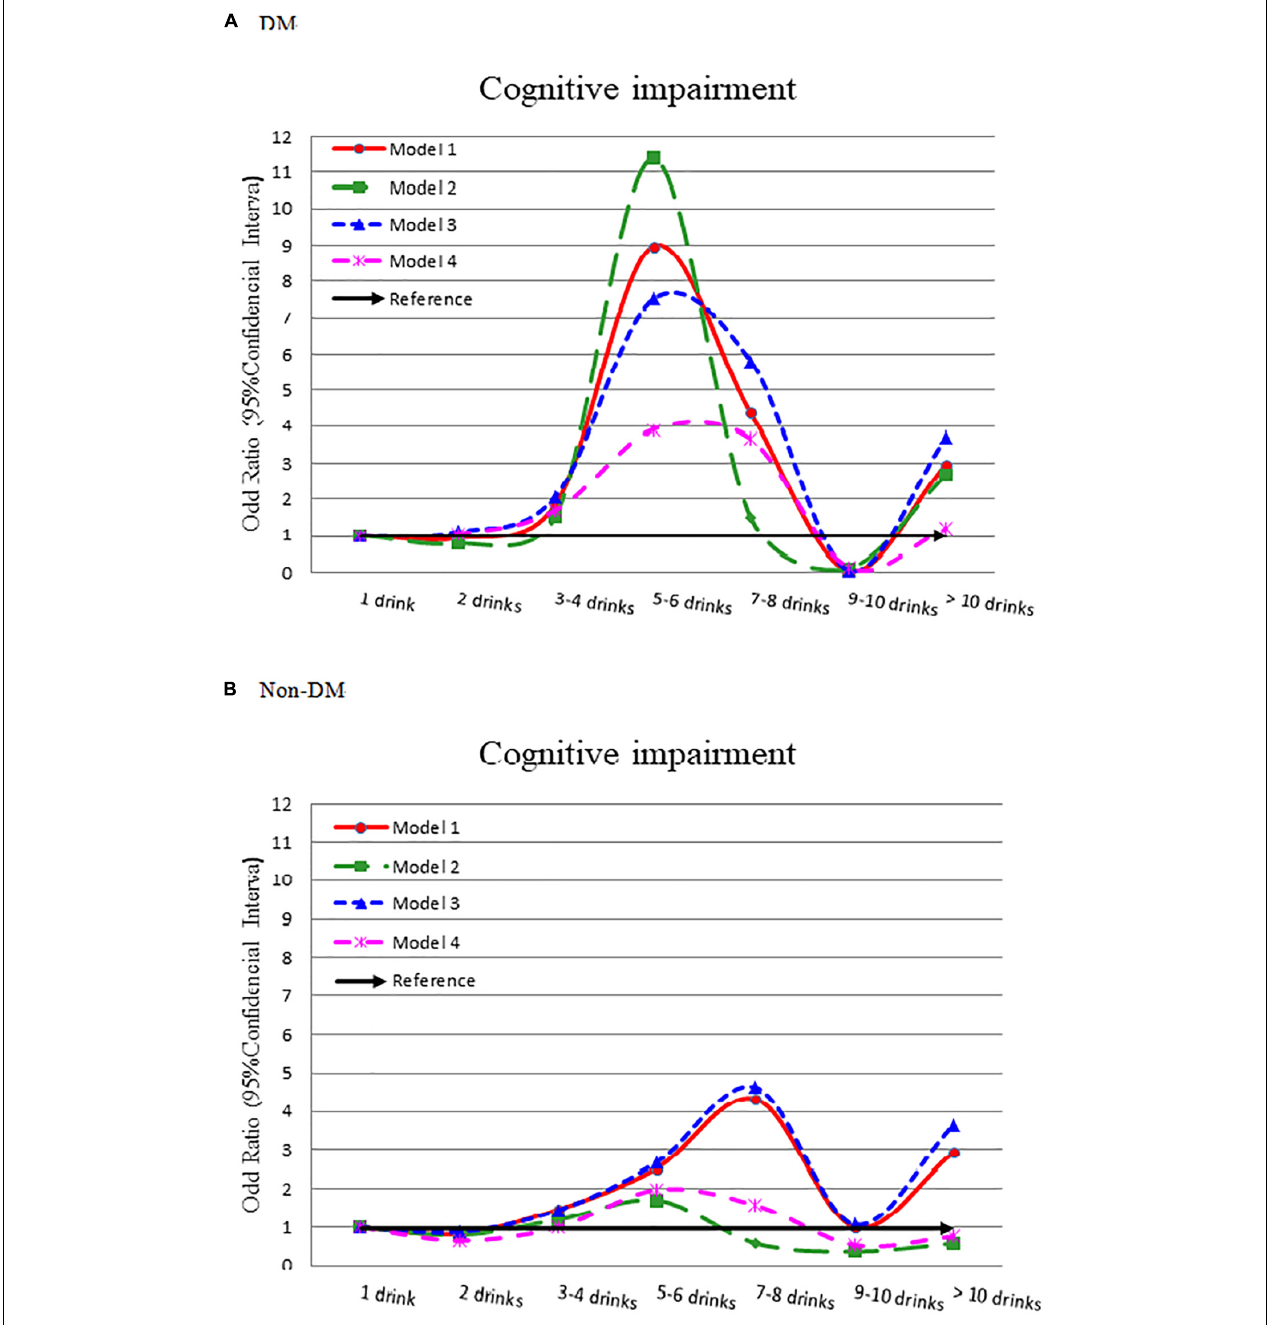
FIGURE 1 | Odds ratio for cognitive impairment by different alcohol consumption categories-stratified by diabetes. (A) With diabetes and (B) without diabetes. Model 1: crude OR (95%CI). Model 2: adjusted for demographic variables. Model 3: adjusted for comorbidity variables. Model 4: adjusted for the significant variables in Supplementary Table 4